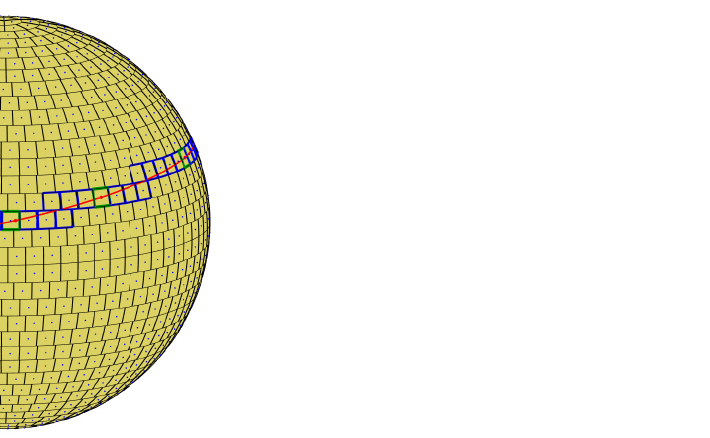
Figure 8. Incrementing all cells through which the continuous voting curve passes means voting for both the blue and green cells. In contrast, sampling θ and quantizing ϕ generates the centers of the green cells alone.